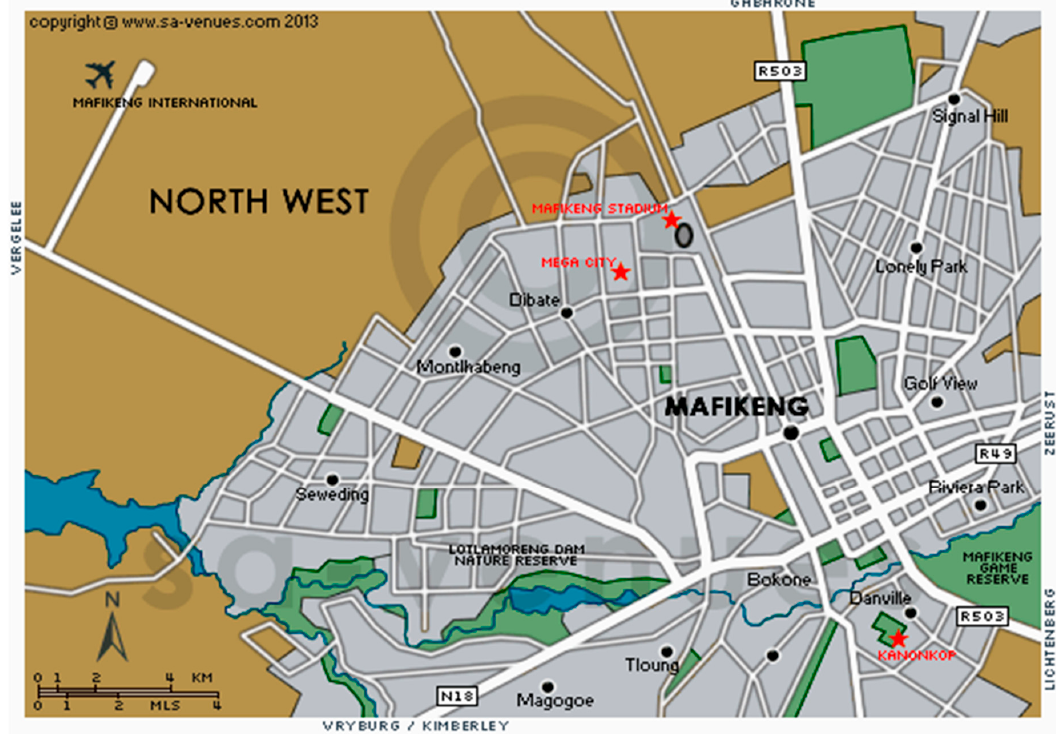
Figure 2. Map of sampling areas in Mafikeng ( www.sa-venues.com ). Accessed 02 November